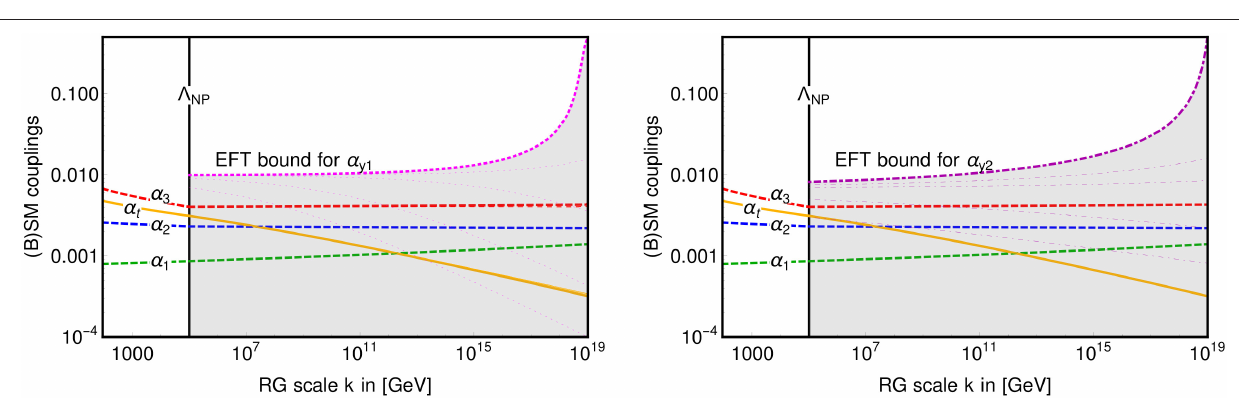
(left) and α y (right) at the Planck scale to the gray-shaded regions at lower scales. 1 2